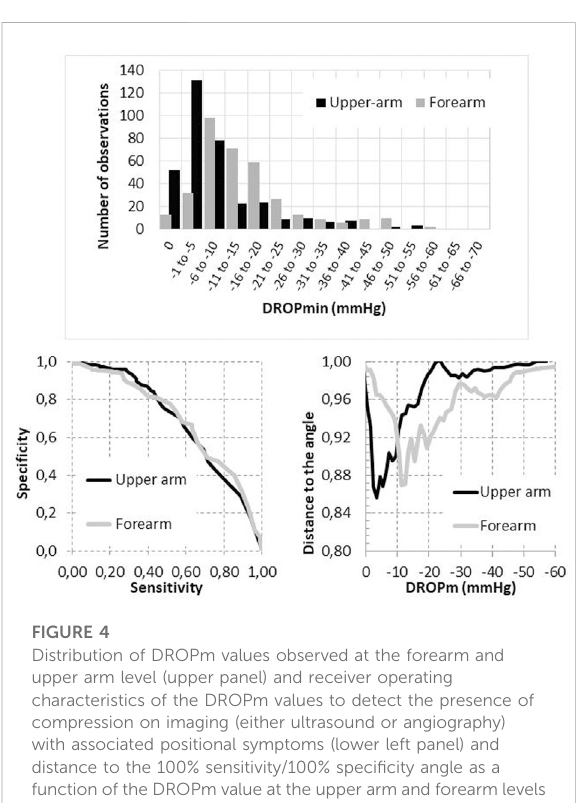
FIGURE 4 Distribution of DROPm values observed at the forearm and upper arm level (upper panel) and receiver operating characteristics of the DROPm values to detect the presence of compression on imaging (either ultrasound or angiography) with associated positional symptoms (lower left panel) and distance to the 100% sensitivity/100% speci fi city angle as a function of the DROPm value at the upper arm and forearm levels (lower right